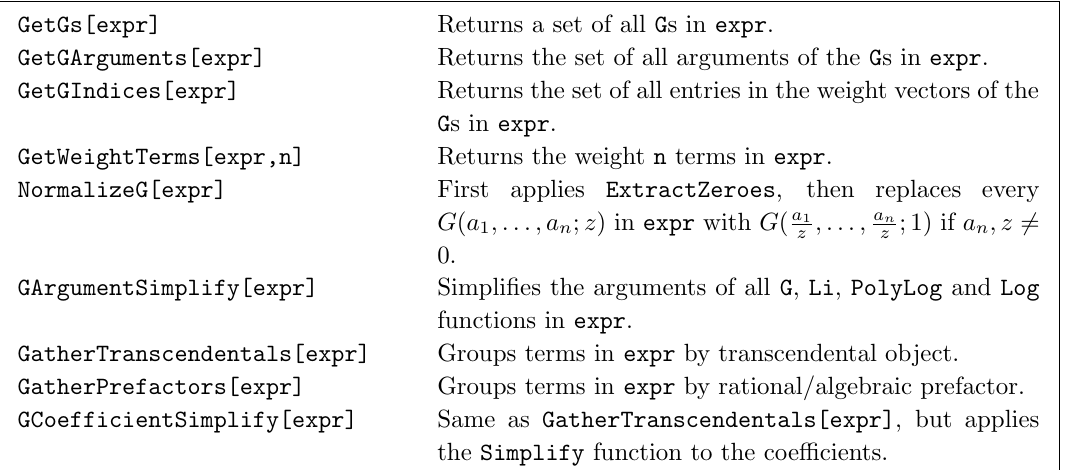
Table 5 . Manipulating